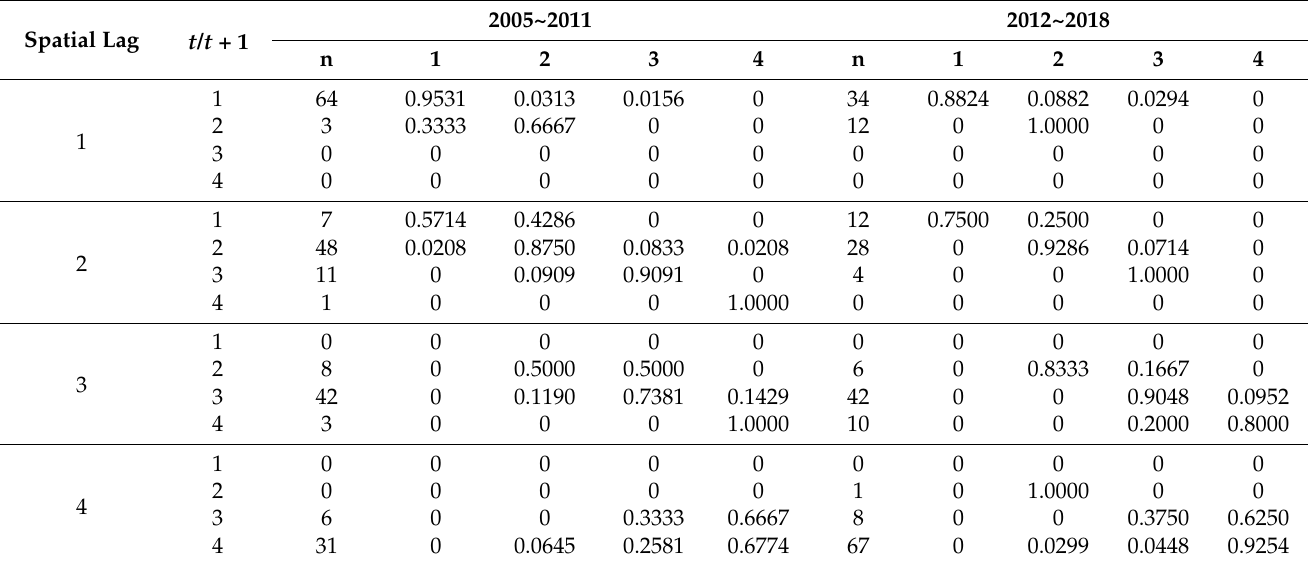
Table 6. Markov transfer probability matrix of the RNCUE type space in Chongqing,